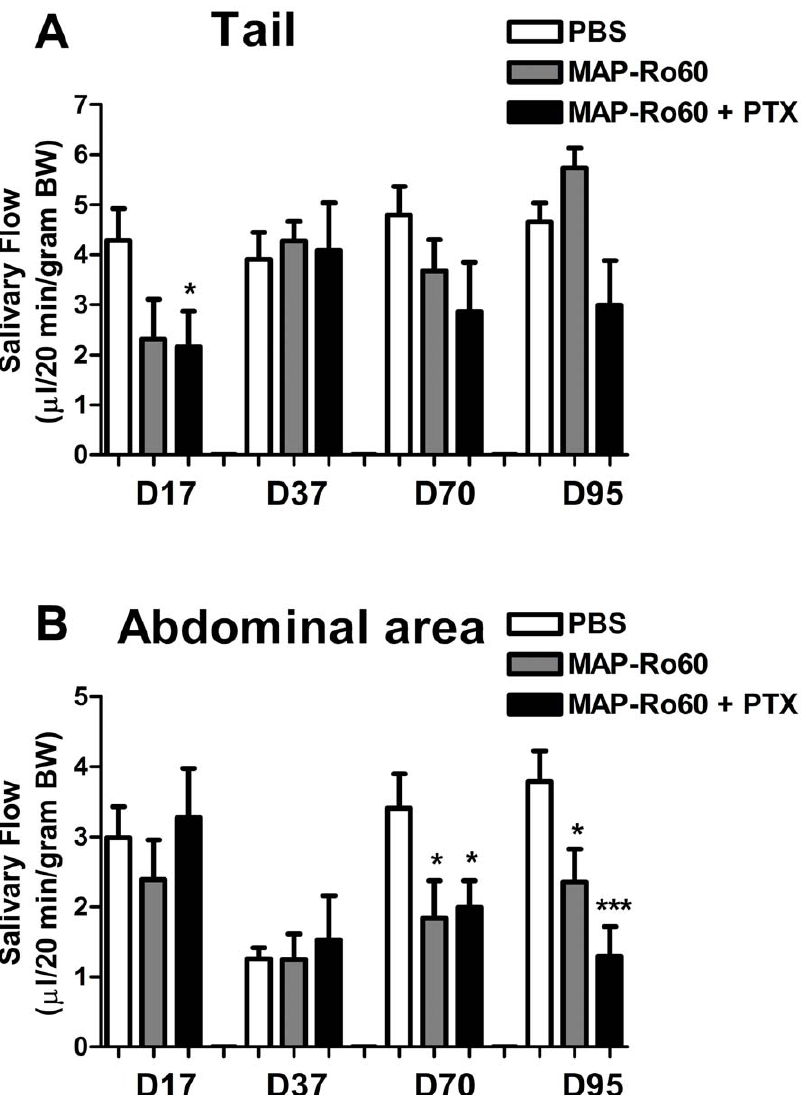
Figure 4. Salivary gland dysfunction in SJL/J immunized with MAP-Ro60 + /- PTX. SJL/J mice were immunized with MAP-Ro60 + /- PTX or PBS (mock) in the tailbase (A) or the abdominal area (B) . Data shown are mean values + /- SEM for 10 mice/group. Significant differences are indicated (*** p , 0.0001; * p , 0.05) and were determined by unpaired Student’s t-test. D: number of days post primary injection.